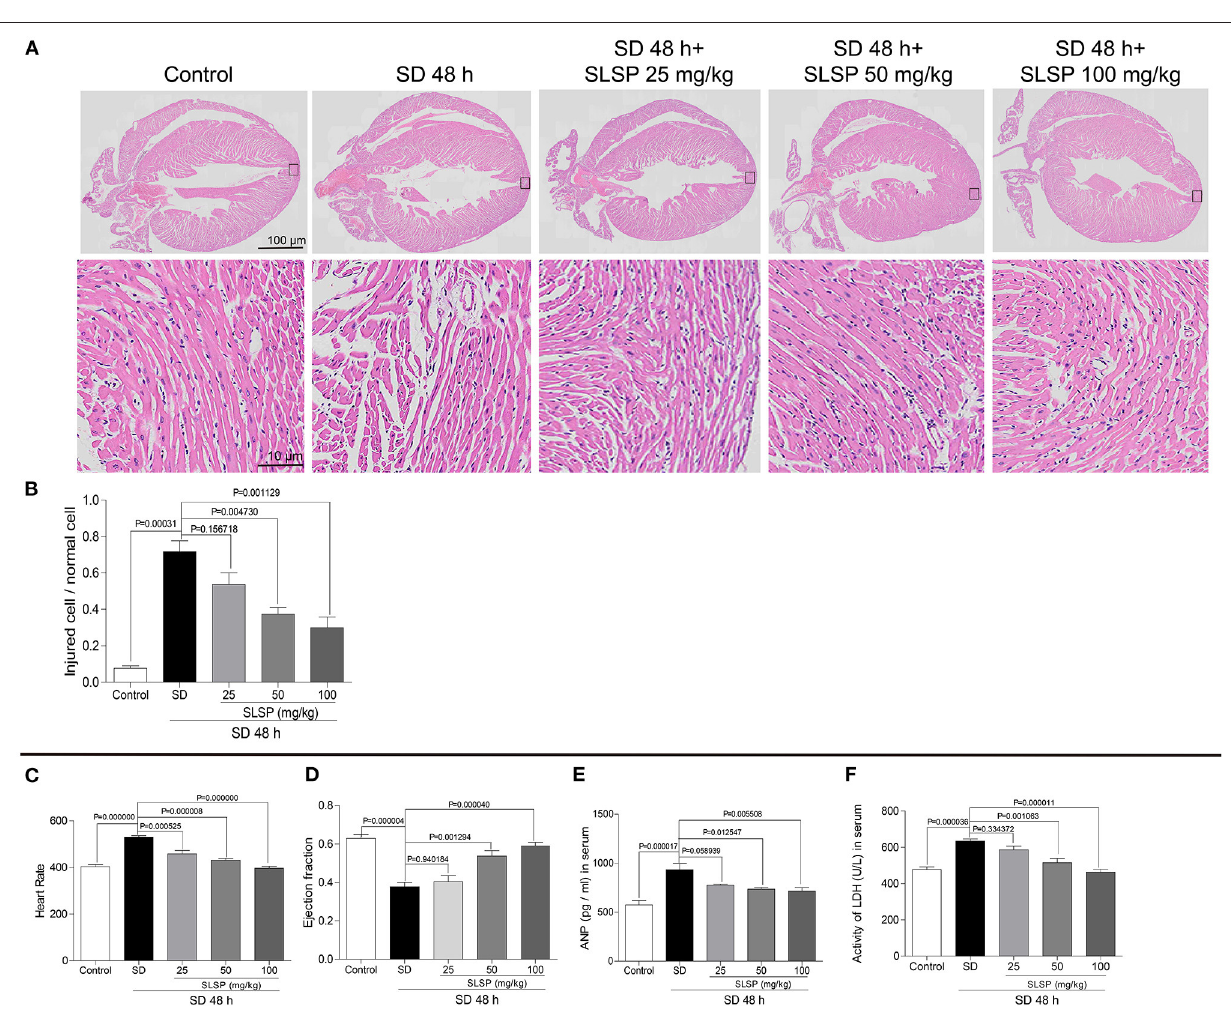
Frontiers in Cardiovascular Medicine |